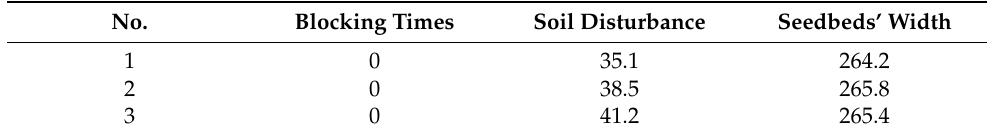
Table 6. Blocking times during the seeding, soil disturbance (%), and width of the seedbeds (mm) after the seeding.